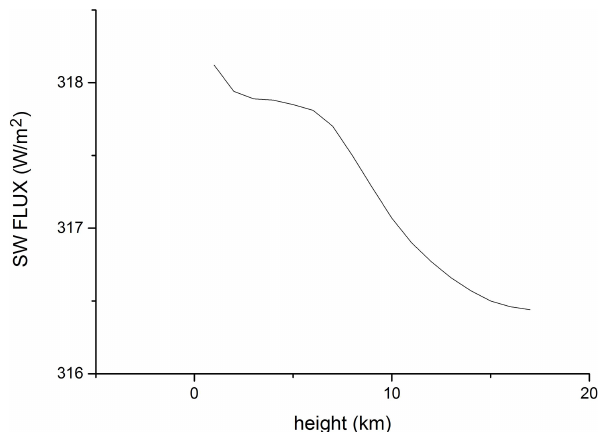
Figure 10. The sensitivity test of SW radiative flux at the TOA to various heights of the dust